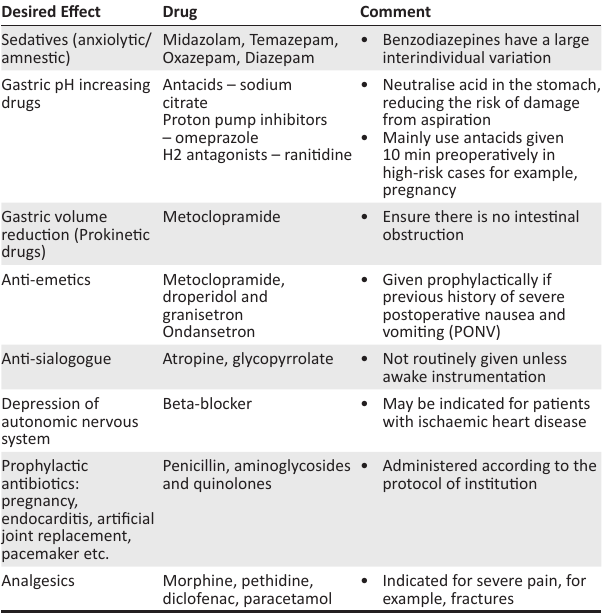
TABLE 4: Drugs used for premedication.